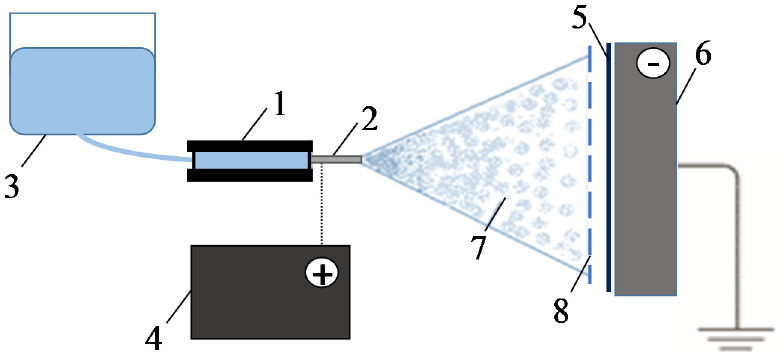
Figure 14. Principal scheme of the setup for the membrane surface modification: 1—high-precision syringe pump, 2—metal needle, 3—polymer solution, 4—high voltage source, 5—modified membrane, 6—cathode, 7—stream of drops of polymer solution, 8—template.